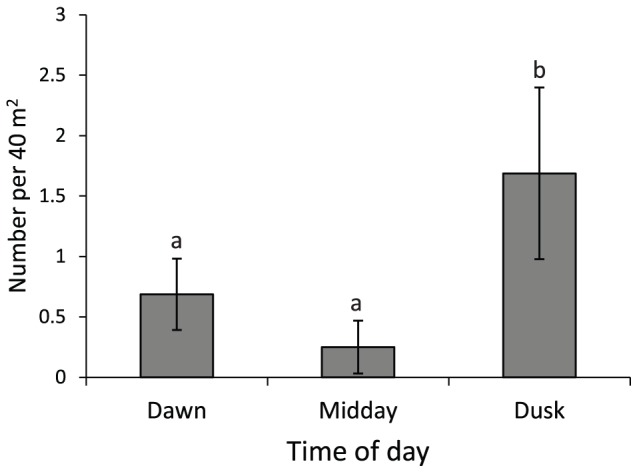
Mean (± SE) number of Cephalopholis cyanostigma visible within 20×2 m visual strip transects, at three times of the day: dawn, midday, and dusk.Letters above bars represent Tukey's HSD homogenous subsets. N = 16.